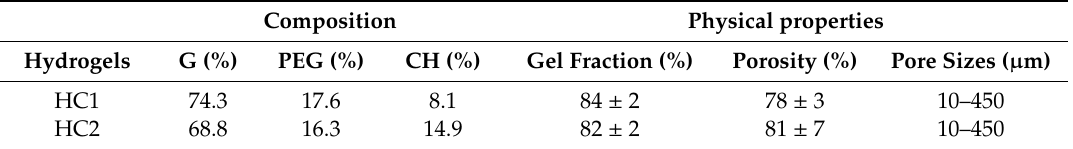
Table 1. Composition and physical properties of the chitosan-based hydrogels.